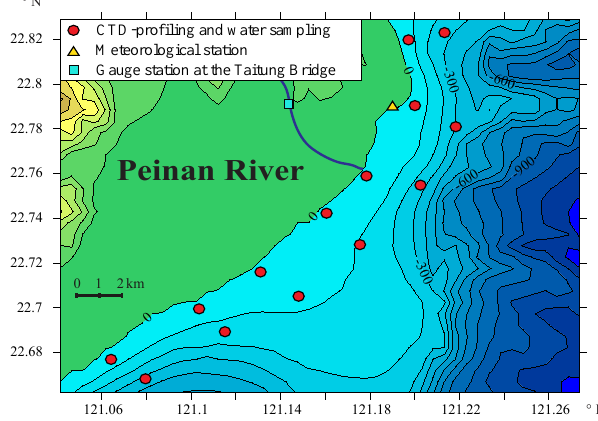
Figure 3. Bathymetry and location of stations in the region of field work conducted on 15–17 April 2014.